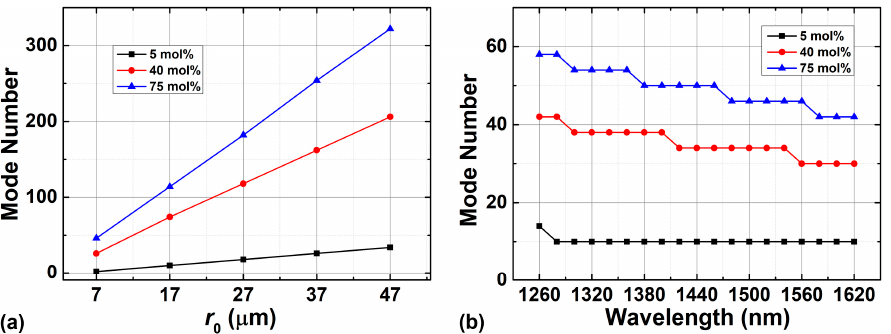
Figure 3. OAM mode number supported in the fiber as a function of ( a ) the position of the ring-core ( r 0 ) and ( b ) wavelength with different mole fractions of GeO 2 .